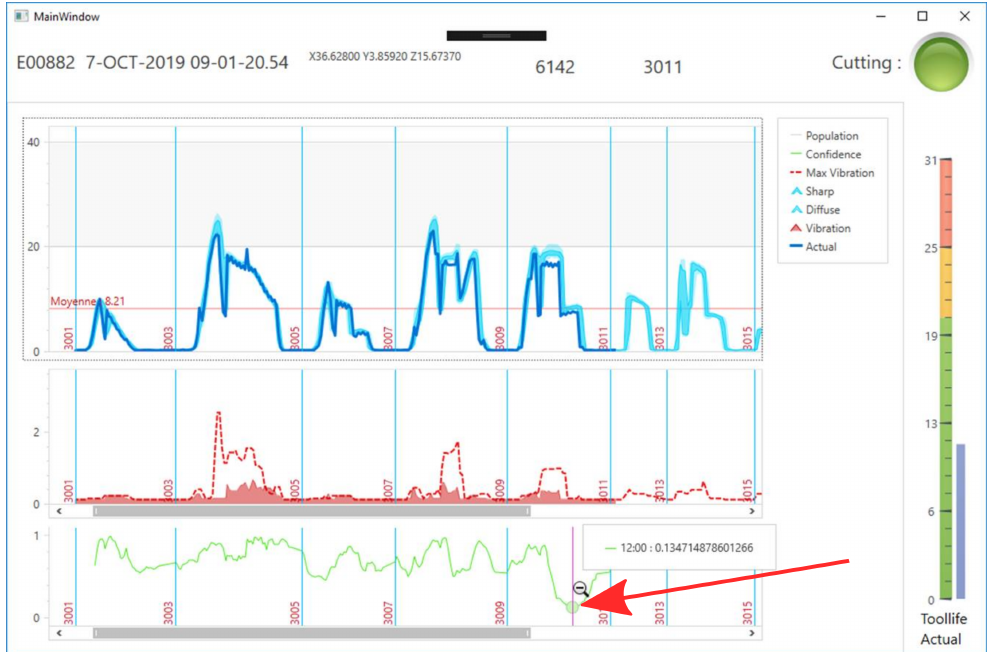
Figure A1. Testing the normal behavior monitoring of program